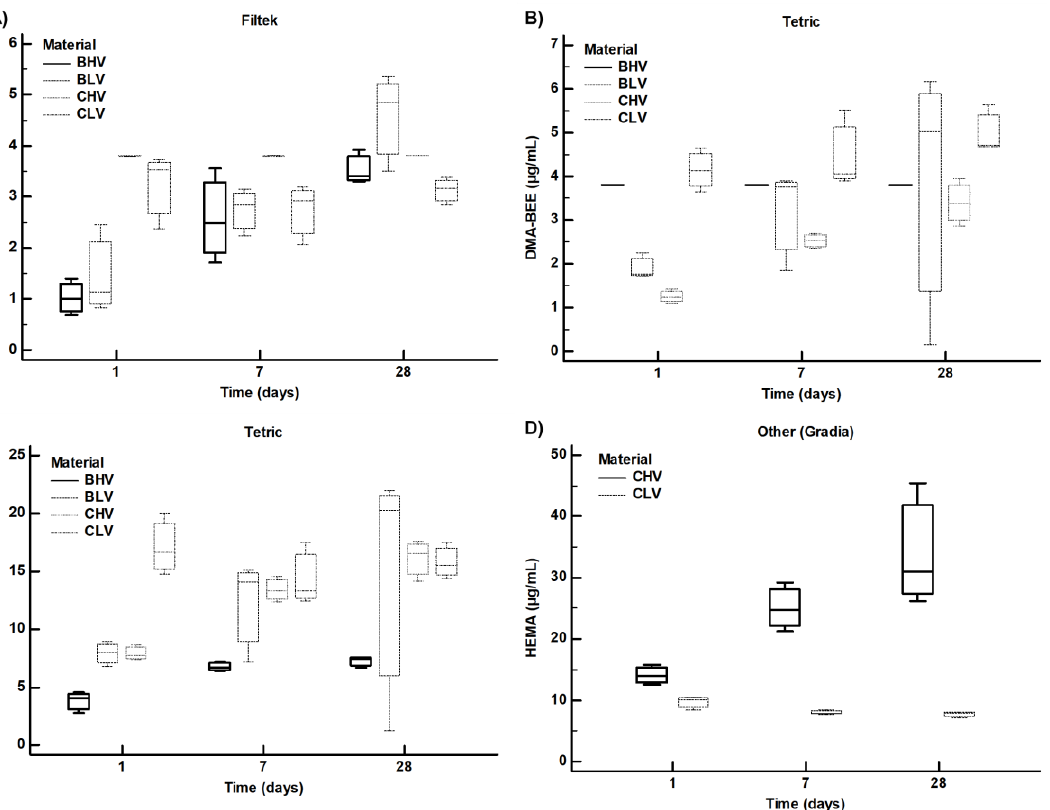
BHV — Bulk high viscosity material, BLV — Bulk low viscosity, CHV — Conventional high viscosity, CLV — Conventional low viscosity. Significant results highlighted in bold. NA — Not applicable. Figure 3. Amounts of leachable compounds detected by LC-MS/MS across different dental materials from the same provider (Filtek Panel ( A ); Tertic Panels ( B , C ); Gradia Panel ( D )) in ethanol medium incubated at 37 Degrees Celsius for 24 h, 7 days or 28 days. BHV — Bulk high viscosity material, BLV — Bulk low viscosity material, CHV — Conventional high viscosity, CLV — Conventional low viscosity. Each material was sampled in three replicates and each replicate is represented by a mean of three LC-MS/MS measurements. Bis GMA (Bysphenil-glycidyl-methacrylate), DMA BEE (4-dimethylaminobenzoic acid ethyl ester), HEMA (2-Hydroxyethyl methacrylate).